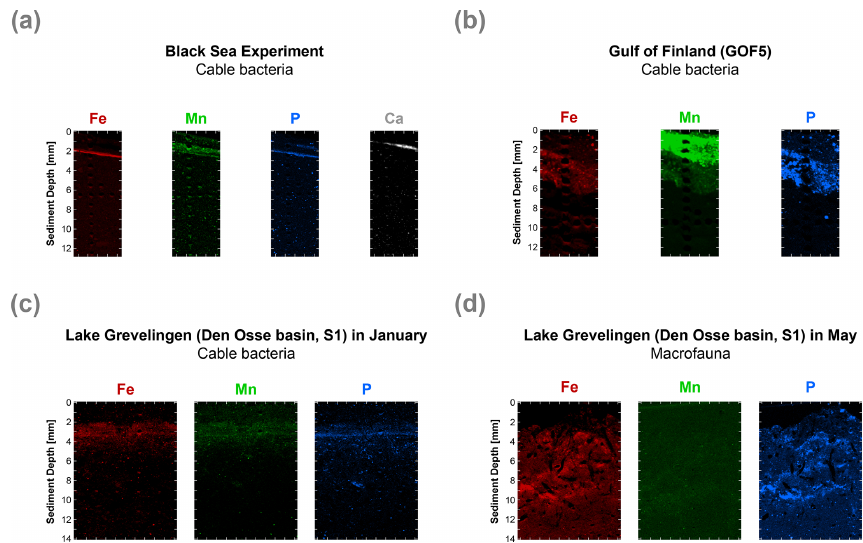
Figure 8. High-resolution elemental maps of Fe (red), Mn (green), P (blue) and Ca (white) of surface sediments. These maps are shown in true vertical orientation, and the colours accentuate the relative count intensities, adjusted for brightness and contrast, to highlight the features in the sediment. The tick marks represent 1mm intervals. µXRF maps of the surface sediment (a) from the incubation experiment, (b) from the Gulf of Finland at site GOF5 in June (Hermans et al., 2020), (c) from Lake Grevelingen (Den Osse basin, S1) in January (when cable bacteria become active) and (d) from Lake Grevelingen (Den Osse basin, S1) in May (showing the effects of bioturbation as described in Seitaj et al.